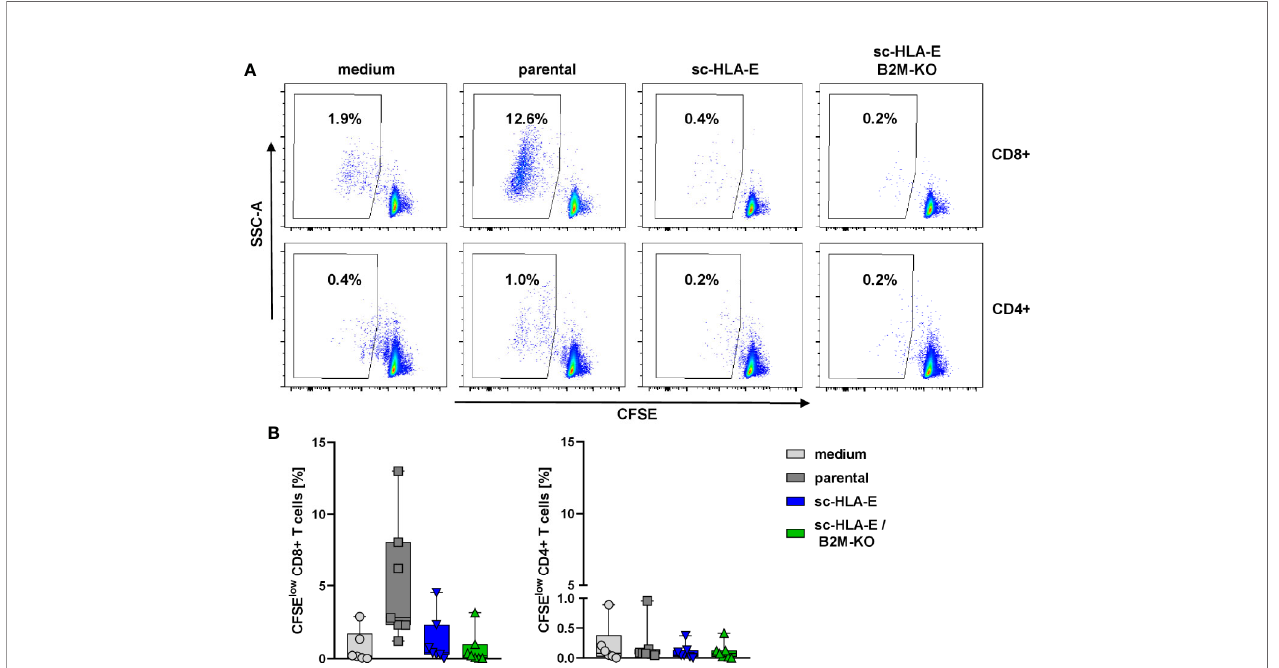
FIGURE 4 | CFSE proliferation assay to measure the immune response of allogeneic T cells towards the modi fi ed NK cells. (A) Representative fl ow plots showing the frequency of CFSE low CD8 + (upper panel) and CD4 + (lower panel) T cells after 6 days of co-incubation with NK cells carrying the modi fi cations depicted above the plots. (B) Quanti fi cation of activated CFSE low CD8 + (left) and CD4 + (right) T cells after co-incubation with the modi fi ed NK cells. Statistical analysis was performed using one-way ANOVA with Holm-Sidak testing for multiple comparisons. The higher frequency of CFSE low CD8 + T cells was statistically signi fi cant compared to sc- HLA-E and sc-HLA-E/B2M-KO NK cells (Box plots including median, quartiles and all data points, n =